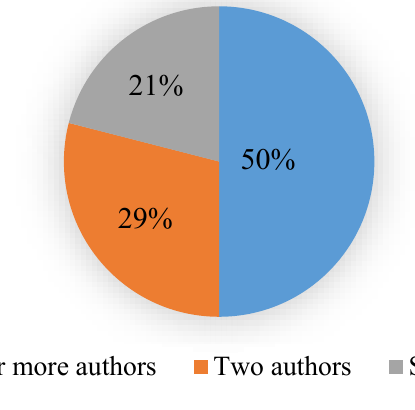
Figure 2. Distribution of studies by number of